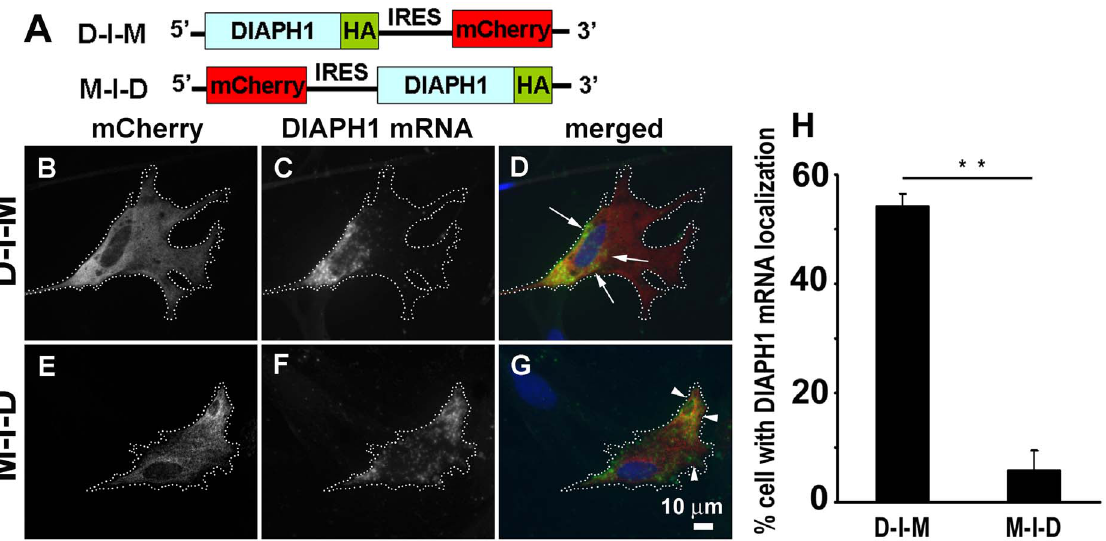
Figure 4. Internal Ribosome entry site mediated translation leads to delocalization of DIAPH1 mRNA. A. Illustration of bicistronic DIAPH1 expression constructs. D-I-M for DIAPH1-IRES-mCherry and M-I-D for mCherry-IRES-DIAPH1. CEF were transfected for 24 hr and processed for DIAPH1 mRNA and HA-tag detection. B–G . Representative transfected cells show localizing DIAPH1 mRNA (green in D , indicated by arrows) and delocalizing DIAPH1 mRNA (green in G , indicated by arrowheads), respectively. Red: mCherry. B–C and E–F are gray scale images for better presentation of the distribution of mCherry protein and DIAPH1 mRNA in cells transfected with the localizing and delocalizing constructs, respectively. H. Quantitative results of DIAPH1 mRNA localization from analysis of 300–500 cells from three independent experiments for each expression construct. Error bars: sem. ** p , 0.01.